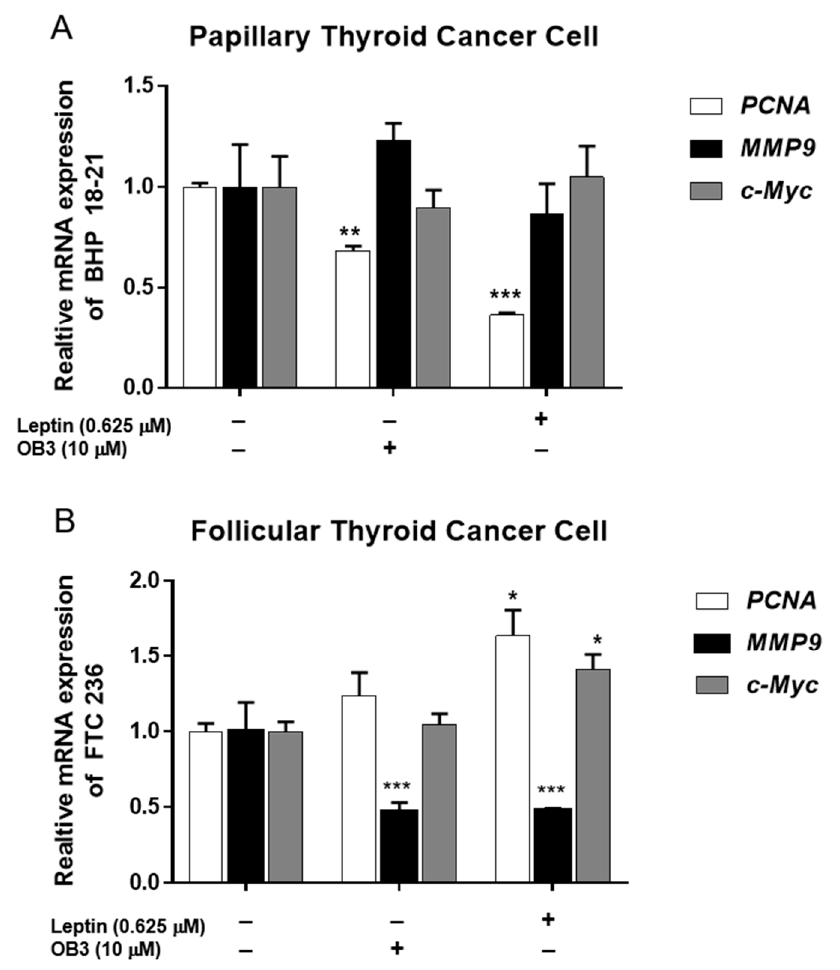
Figure 4. Effect of OB3 and leptin peptides on expression of genes relevant to invasion and cell proliferation in thyroid cancer cell lines. ( A ) Papillary and ( B ) follicular thyroid cancer cells were treated with either 0.625 µM leptin or 10 µM OB3 for 24 h. Cells were harvested, and total RNA was extracted. qPCR for PCNA , MMP9 and c-Myc was conducted as described in Yang et al. [5]. Data were expressed as mean ± S.D. in triplicate. * p < 0.05, ** p < 0.01, *** p < 0.001, were compared with control.